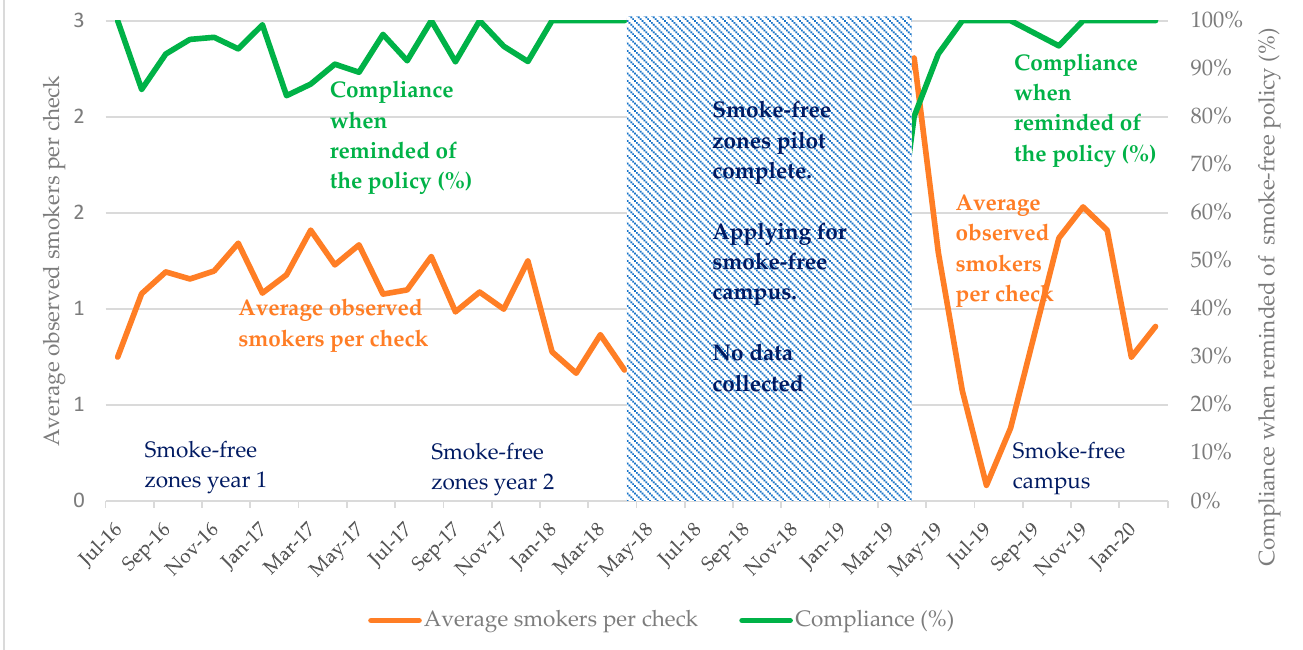
Figure 3. Monthly trends in average observed smokers per check (adherence) and percent compliance when reminded of the policy.